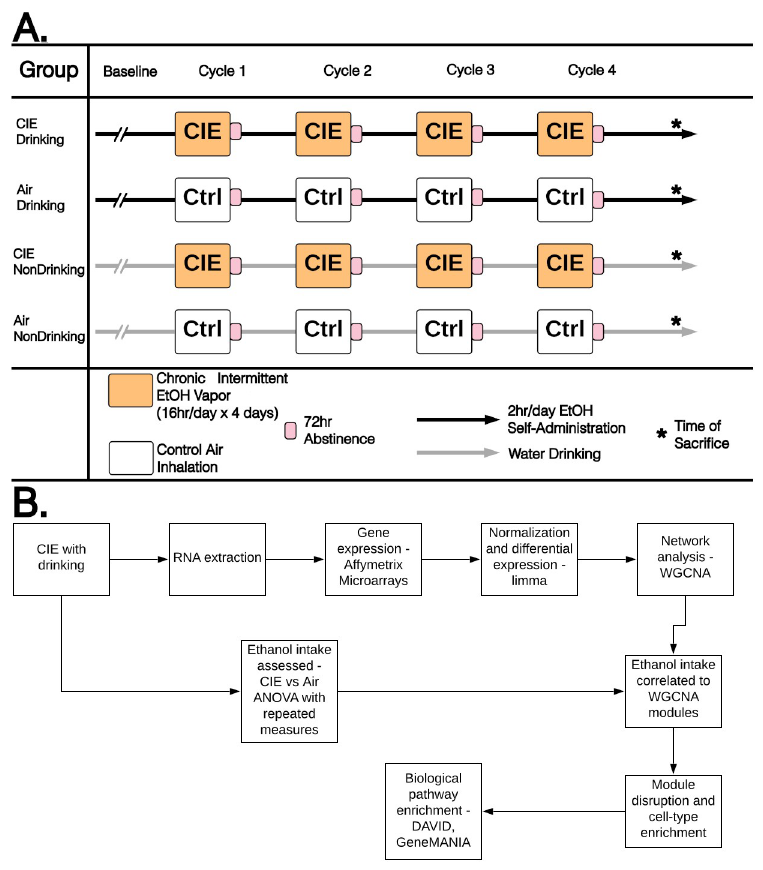
Fig 1. Behavioral and genomic data analysis experimental designs. A) Schematic representation of CIE and drinking experimental design. B) Flow chart detailing step-by-step procedures in genomic data analysis.